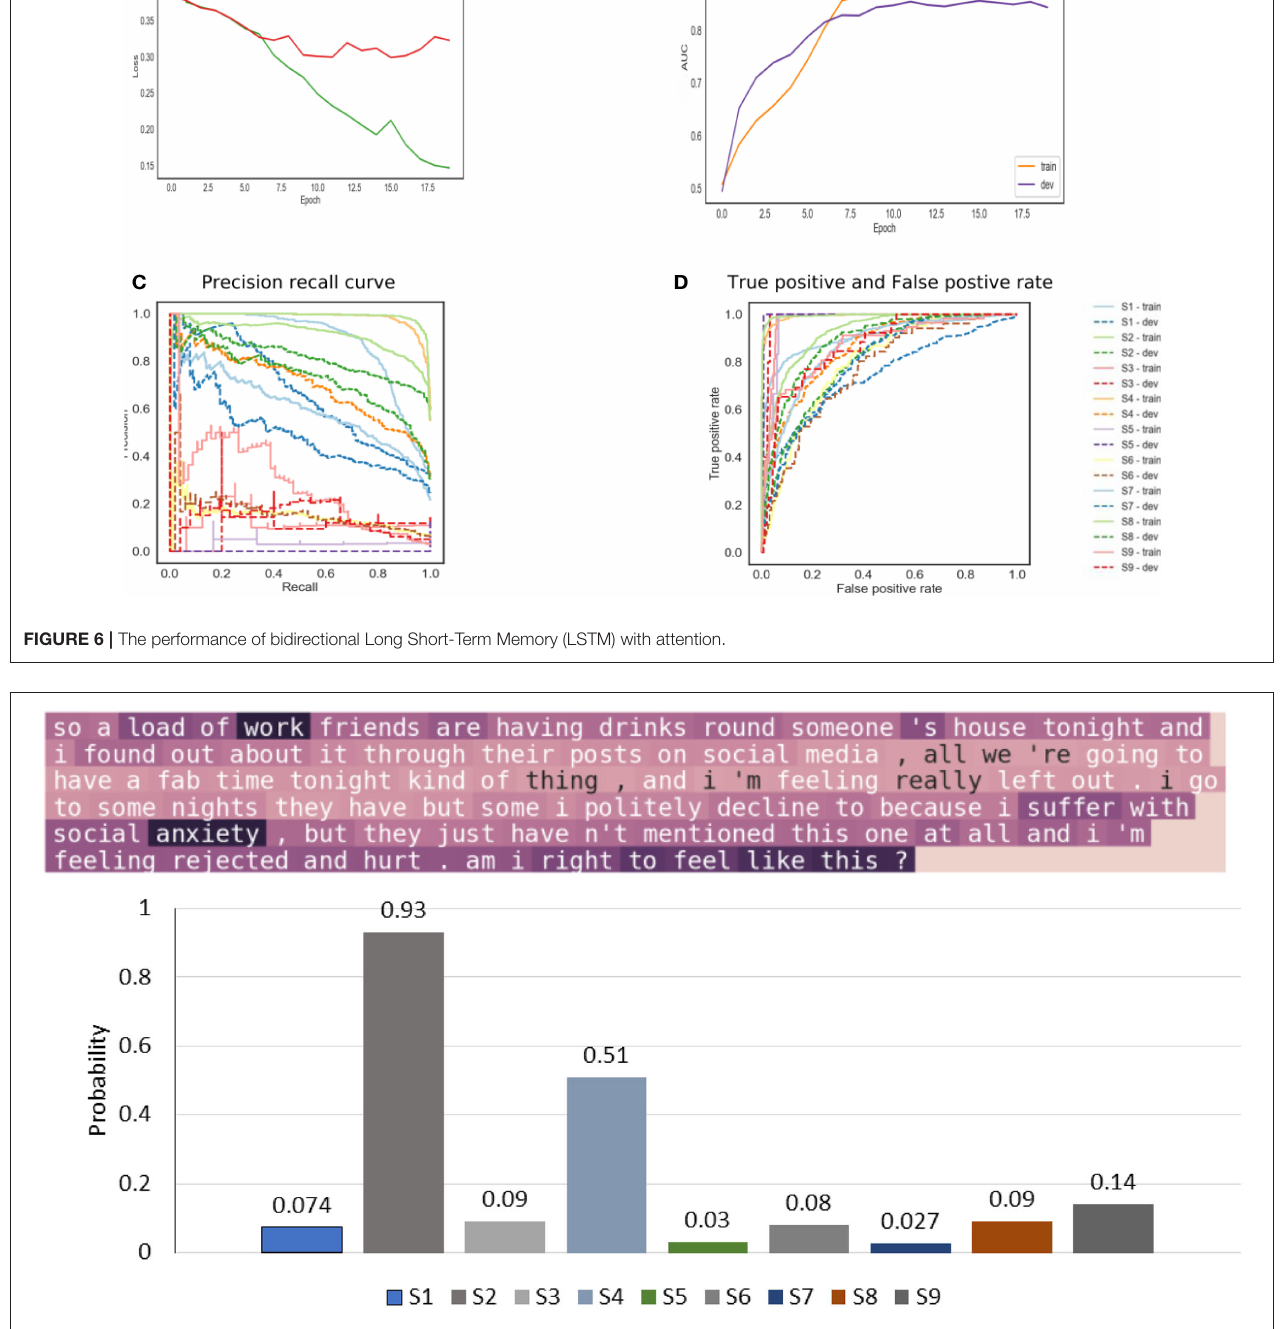
energy). The model also successfully highlights the critical points and the relevant words for the symptoms that is helpful for classifications